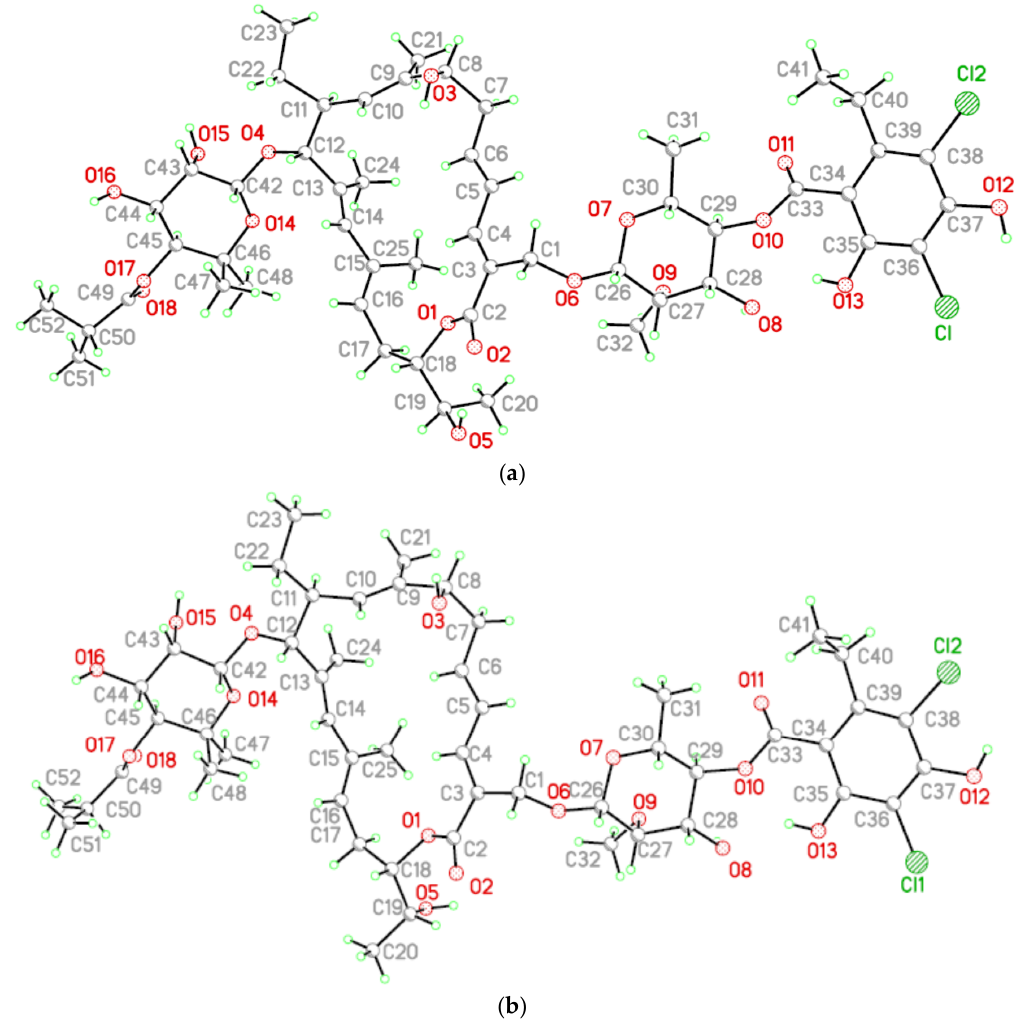
Figure 5. The molecular structure of tiacumicin B showing the two independent molecules in the unit cell with the atomic labelling schemes: ( a ) mol A and ( b ) mol B. This finding confirms that lipiarmycin A3 and tiacumicin B correspond to two different